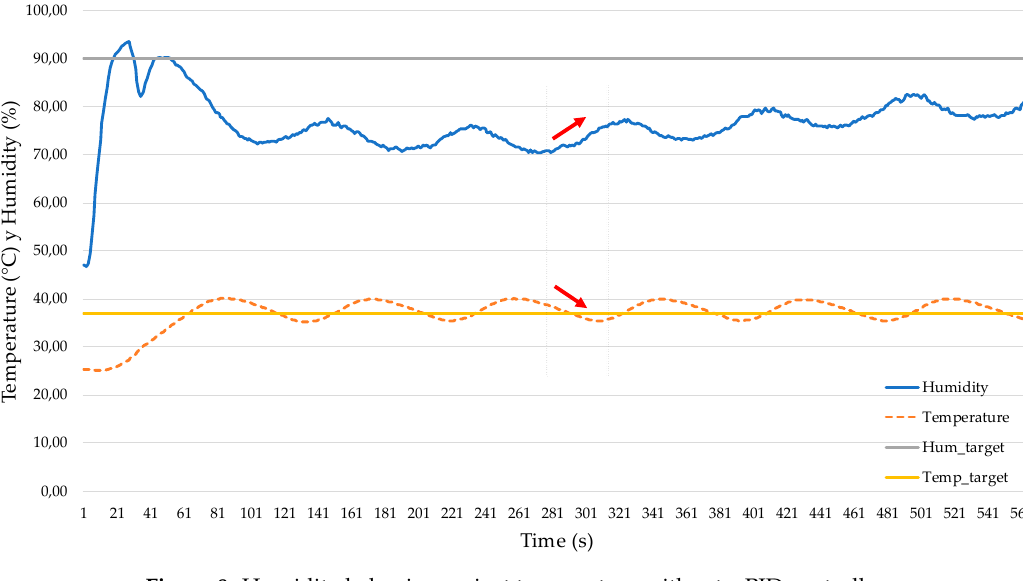
Figure 8. Humidity behavior against temperature without a PID controller.